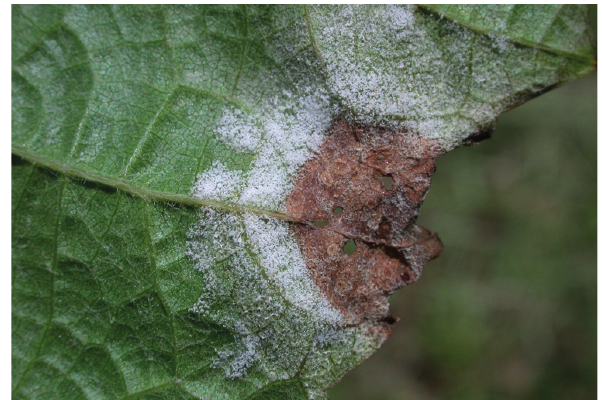
Figure 4. Sporulation of Plasmopara viticola on abaxial leaf surface.